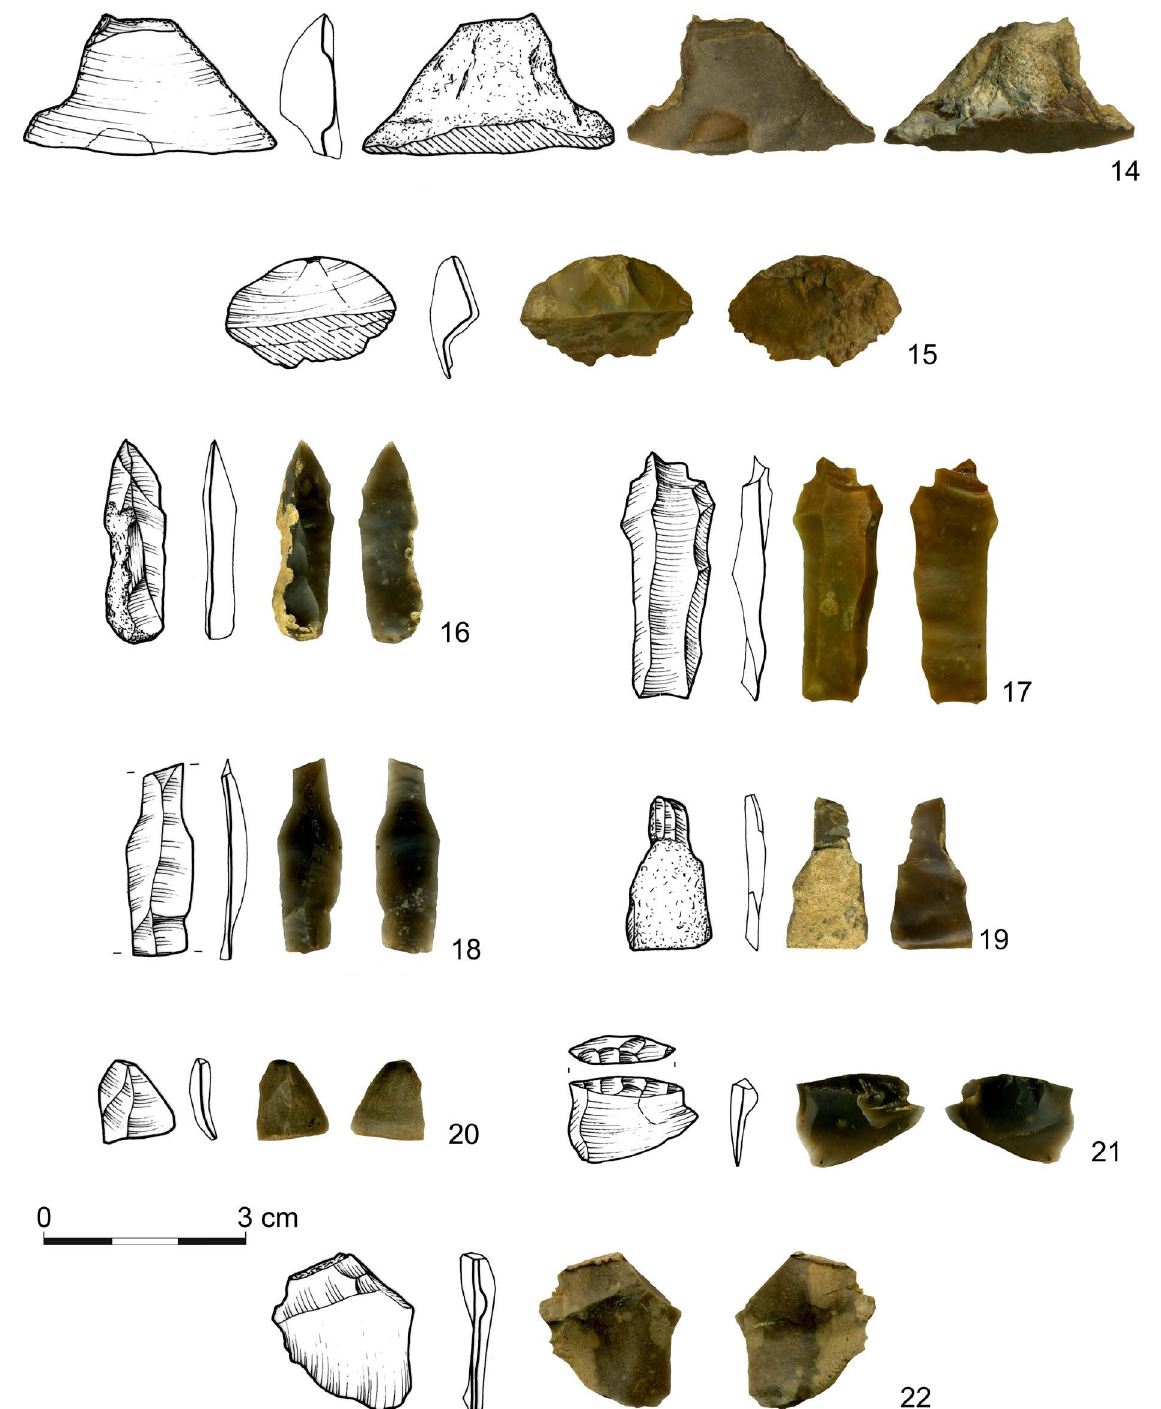
Figure 4. Weklice, Elbląg County. Flint artefacts: 14 . flake fragment; 15. initial flake; 16. partially initial blade; 17. crested blade; 18. blade with scars on the dorsal surface; 19. partially initial flake; 20. microflake with negative flake scars on the dorsal surface; 21. flake with negative flake scars on the dorsal surface; 22. flake with negative flake scars on the dorsal surface. (Drawing by E. Gumińska, E. Pazyna and D. H. Werra. Photo by M. Natuniewicz- Sekuła.